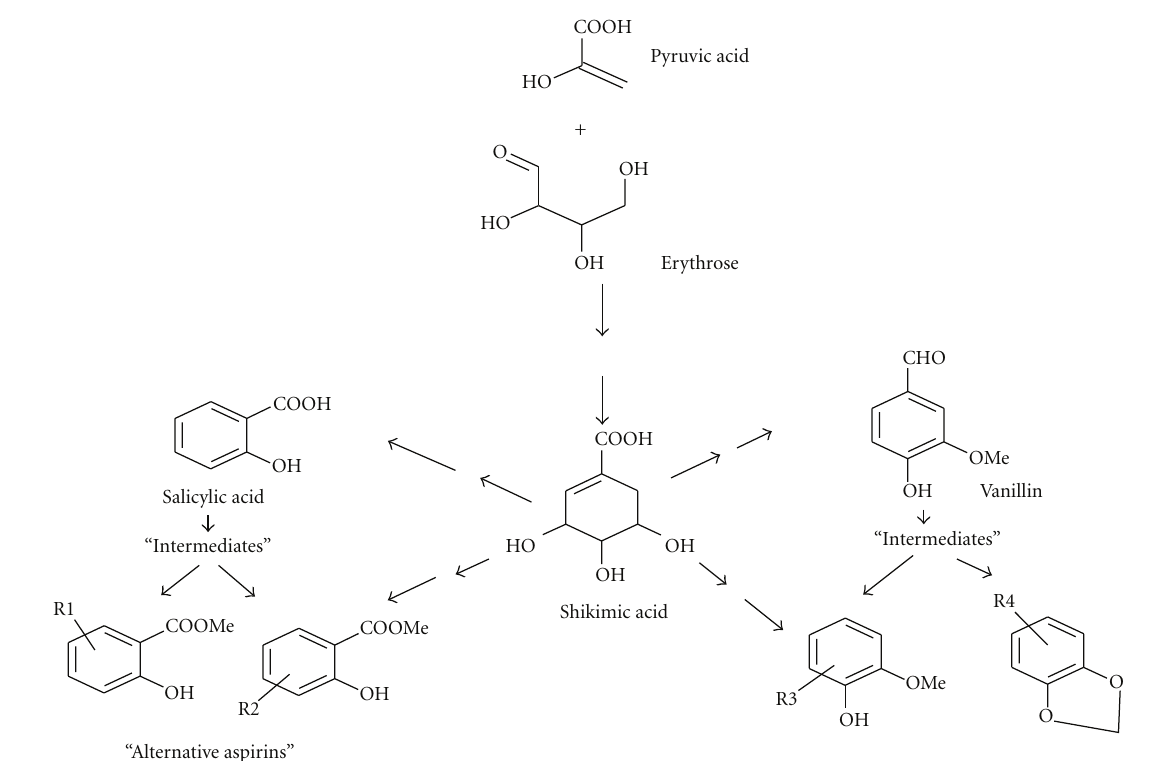
Figure 2: Biosynthesis and relationship of shikimic acid to “alternative aspirins” and “vanilloids”. The shikimic acid pathway is a key biosynthetic pathway for several phytochemicals known for their medicinal attributes. The Figure illustrates the biosynthesis of shikimic acid from pyruvic acid and erythrose and the relationship between the acid and its byproducts and intermediates, some of which possess aspirin-like e ff ects, like analgesia and desickling of sickled RBCs. Such byproducts/intermediates include salicyclic acid derivatives, vanillin, piperine, capsaicin, and cubebin. Piperine, capsaicin, and cubebin as byproducts of shikimic acid are the likely antisickling agents